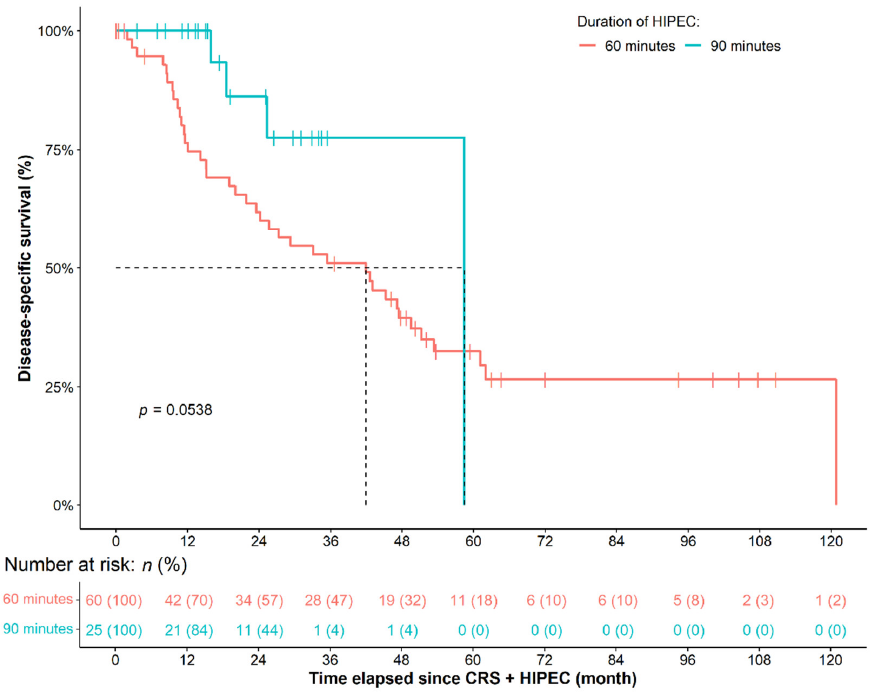
Figure 2. Survival of primary ovarian cancer patients, who received 60 or 90 min-long HIPEC treatment. CRS: cytoreductive surgery; HIPEC: hyperthermic intraperitoneal chemotherapy.